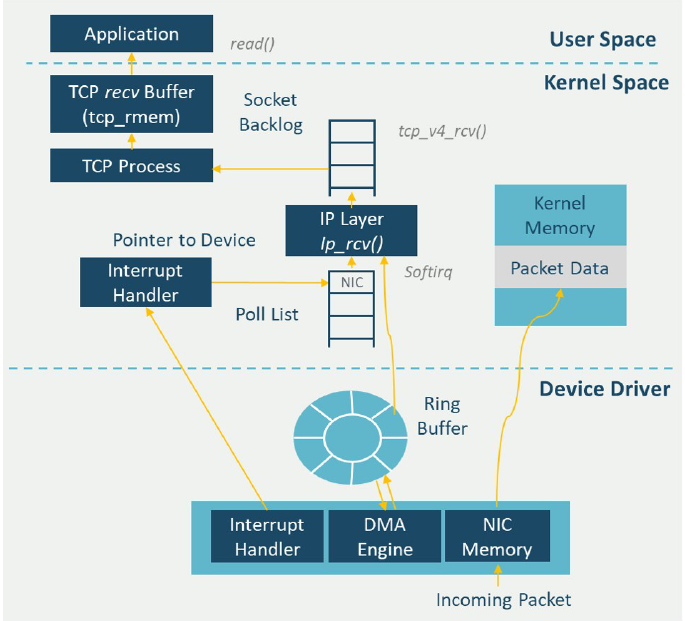
Figure A1. Linux packet processing